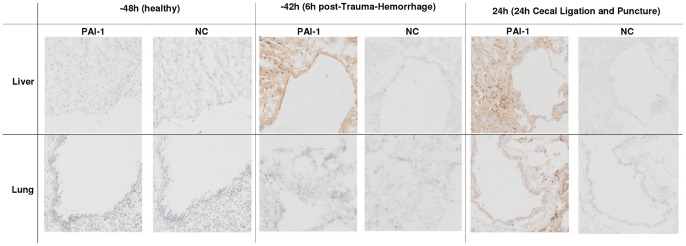
Immunohistochemical staining of PAI-1 in the liver and lung post-TH and TH-CLP.3 week-old mice were subjected to trauma and hemorrhage (TH) at −48 h followed by mild (23G) cecal ligation and puncture (CLP) sepsis at 0 h. At −48 h, −42 h and 24 h, mice were sacrificed and organs were collected and stained for plasminogen activator inhibitor type 1 (PAI-1) in the liver and lung. Representative images for 3–6 animals per time point per tissue are shown. NC, negative control for PAI-1 (incubated without primary antibody). Original magnification x100.